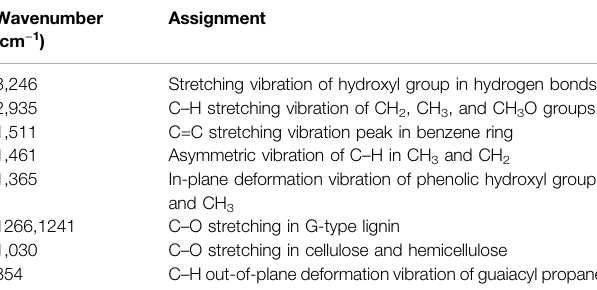
TABLE 1 | Fourier transform infrared peak assignments in alkali lignin samples.